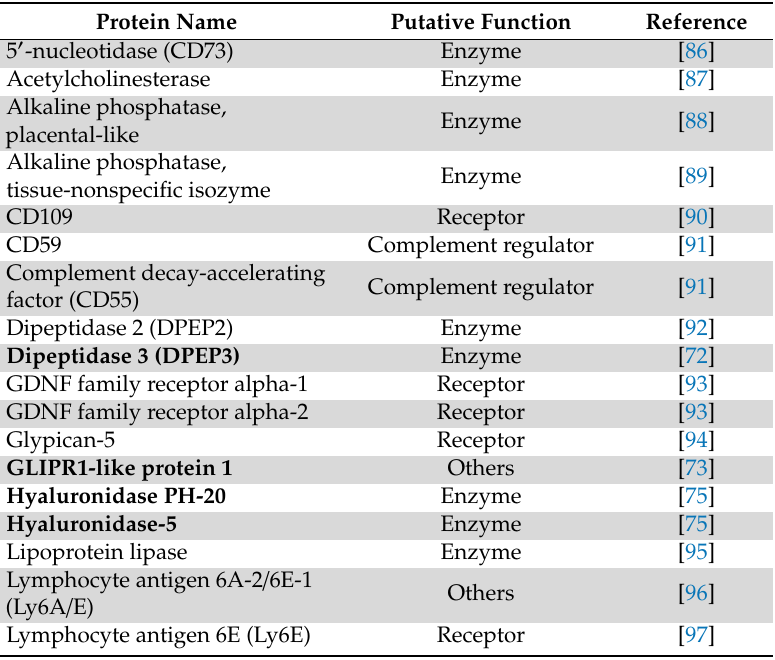
Table 1. GPI-APs expressed within the